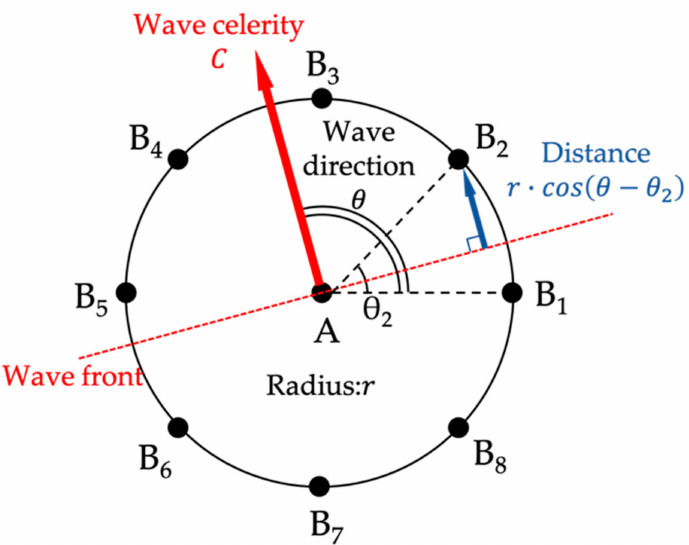
Figure 6. The circular array for estimating wave parameters ( N = 8). Point A indicates the analysis point, and B n is the n- th reference point along the circumference of radius r